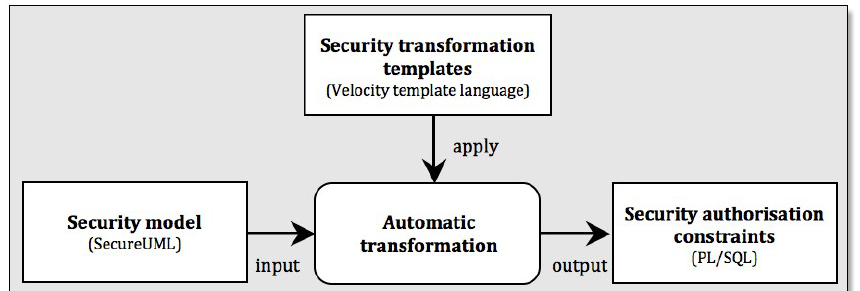
Figure 11. Security model